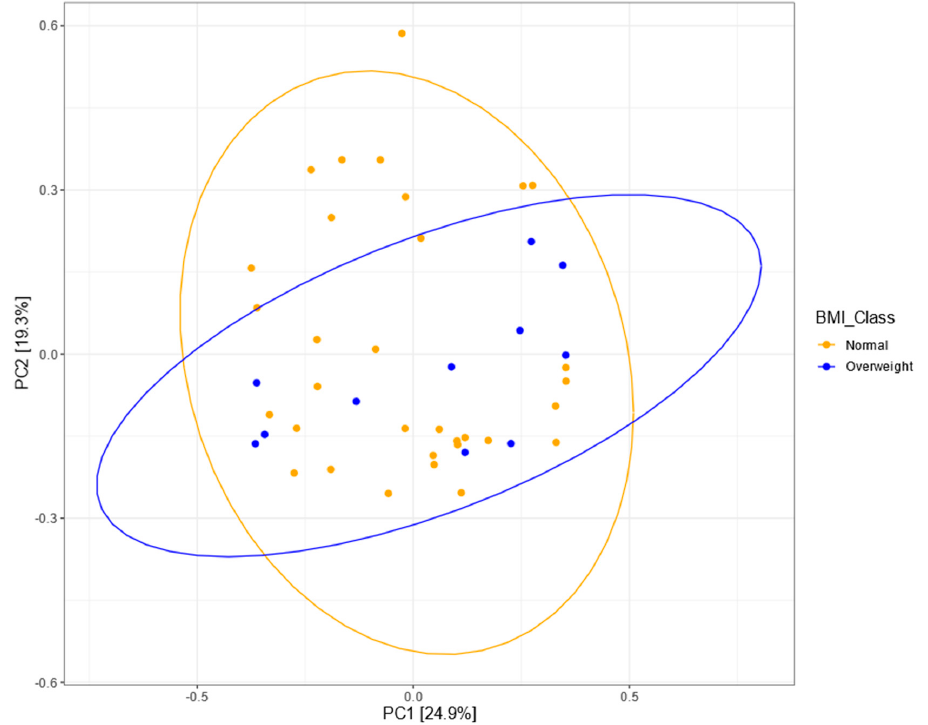
Figure 5. PCoA plot using Bray–Curtis dissimilarity. The 95% confidence ellipses are drawn around the BMI groups. the BMI